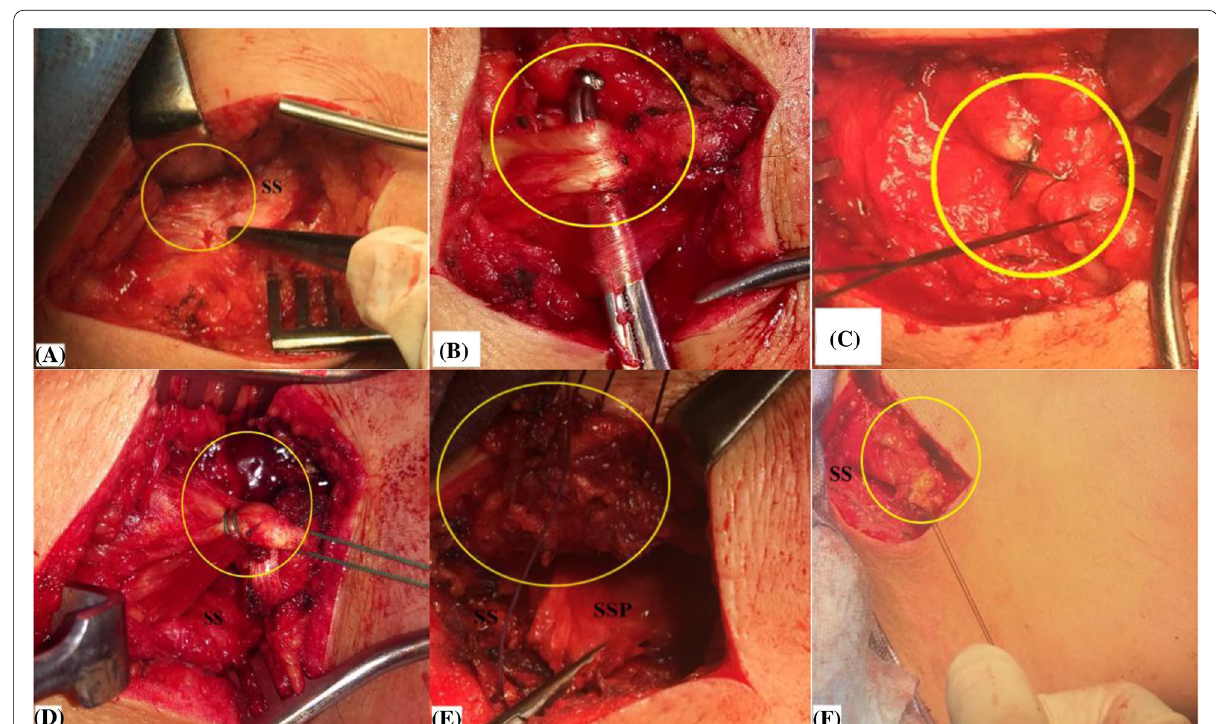
Fig. 7 A, B, C, D, E, F demonstrate release of medial portion (marked in yellow circle) of the middle trapezius insertion tendon in the right − − − − − shoulder. A and B, identification of the tendon insertion into the scapular spine; C, suture tagging of the tendon to facilitate next steps of tendon release and excursion testing; D, tendon release in a lateral‑to‑medial direction up to the medial scapular border; E, blunt dissection of the released tendon from underlying atrophied supraspinatus muscle; F, testing the released tendon for free and adequate excursion; SS, scapular spine; SSP, supraspinatus